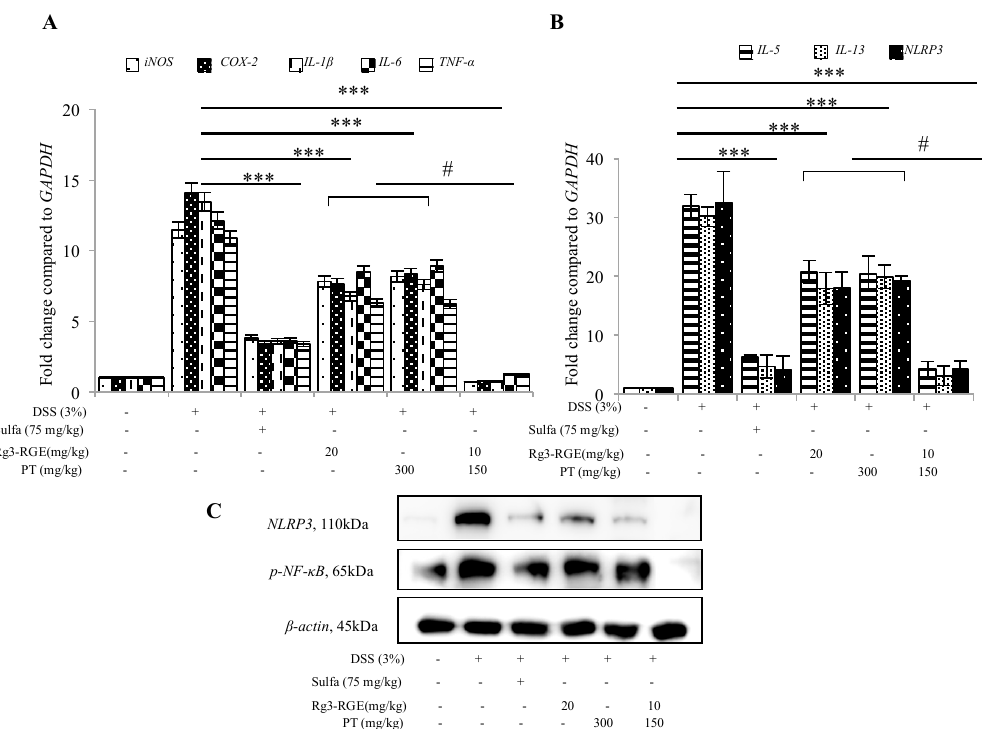
Figure 7. Inhibition of mRNA of pro-inflammatory cytokines, NLRP3 and NF- κ B protein expression by Rg3-RGE + PT. Total RNA and proteins were extracted from colon tissue of DSS-treated mice. mRNA was subjected to qRT-PCR and the expression of pro-inflammatory mediators and cytokines determined by SYBR (Synergy Brand, Inc) green fluorescence. Nuclear and cytosolic proteins were extracted using NE-PER ® Nuclear and cytosolic extraction reagents. ( A , B ) qRT-PCR for iNOS , COX-2 , IL-1 β , IL-6 , TNF- α , IL-5, IL-13 , and NLRP3 . ( C ) Western blot for NLRP3 and NF- κ B . β -actin was used as an internal control. Images are representative of three independent experiments. Values in bar graphs represent mean ± SD of three independent experiments. *** p < 0.001 was considered significant compared to DSS group and # p < 0.01 compared to inhibition by only Rg3-RGE or PT. Experiments were completed within one week of termination.